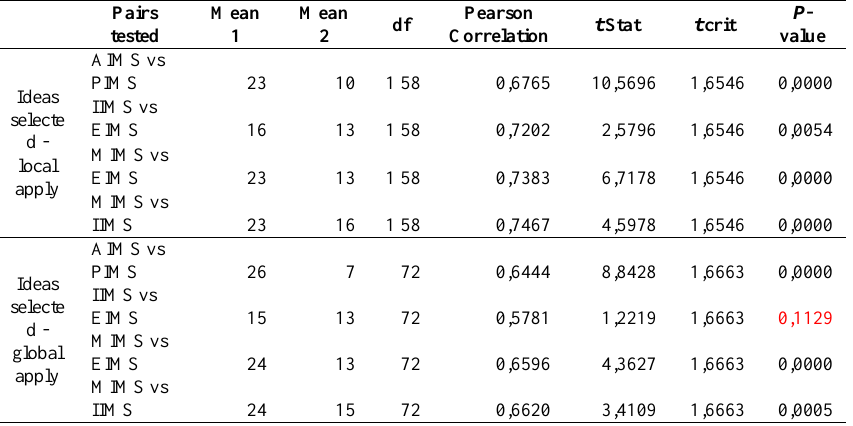
Table 7. t -tests for pairs of average ideas selected by IMS and apply types Pairs tested